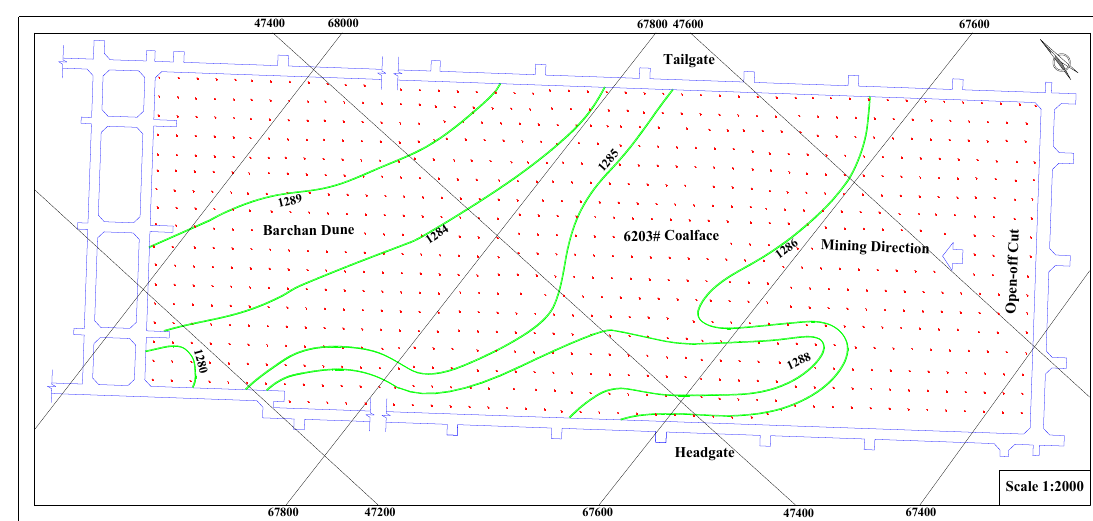
Figure 4. Layout of the 6203# coalface.